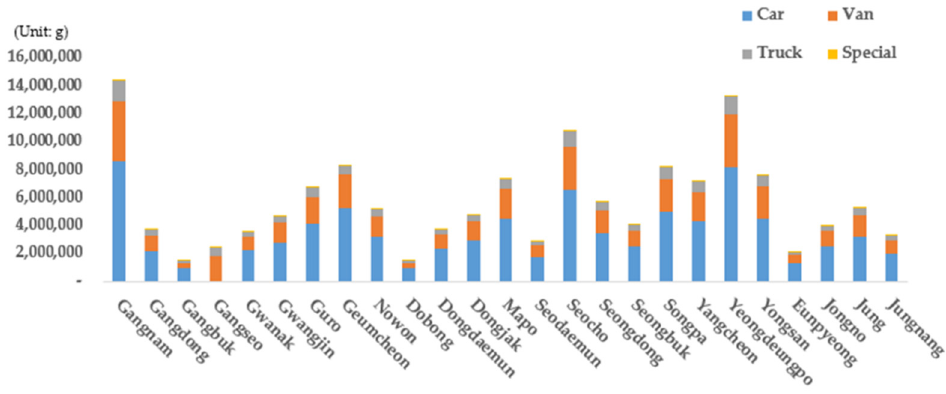
Figure 12. Scenario 1 vehicle emissions by autonomous district ( Gu ) and vehicle type.